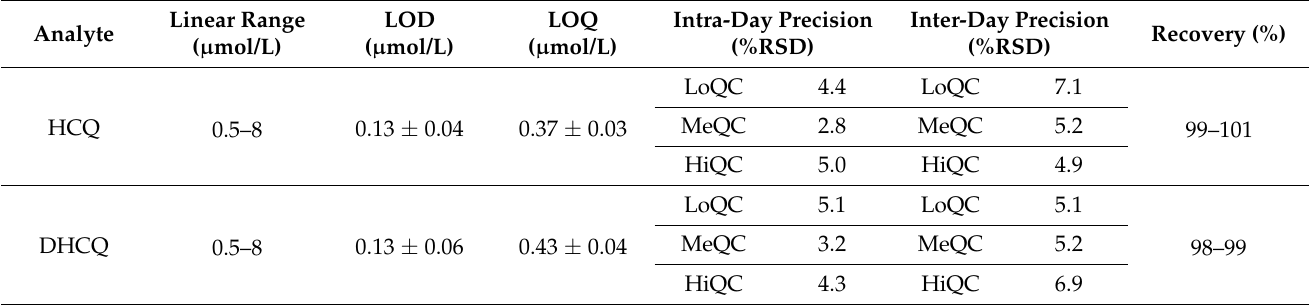
Table 1. Summary of validation parameters of the assay. Concentrations for LoQC, MeQC, and HiQC were 0.6, 3.2, and 7.0 µmol/L, respectively.